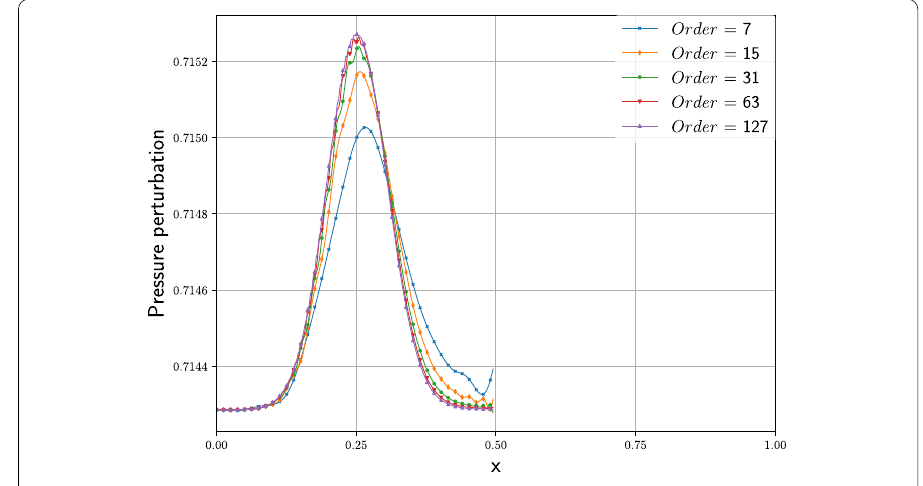
Fig. 4 Plot for the pressure perturbation of the reflected wave at t = 0.5 for different orders. The numerical reference solution is obtained with a traditional wall boundary condition and a high resolution